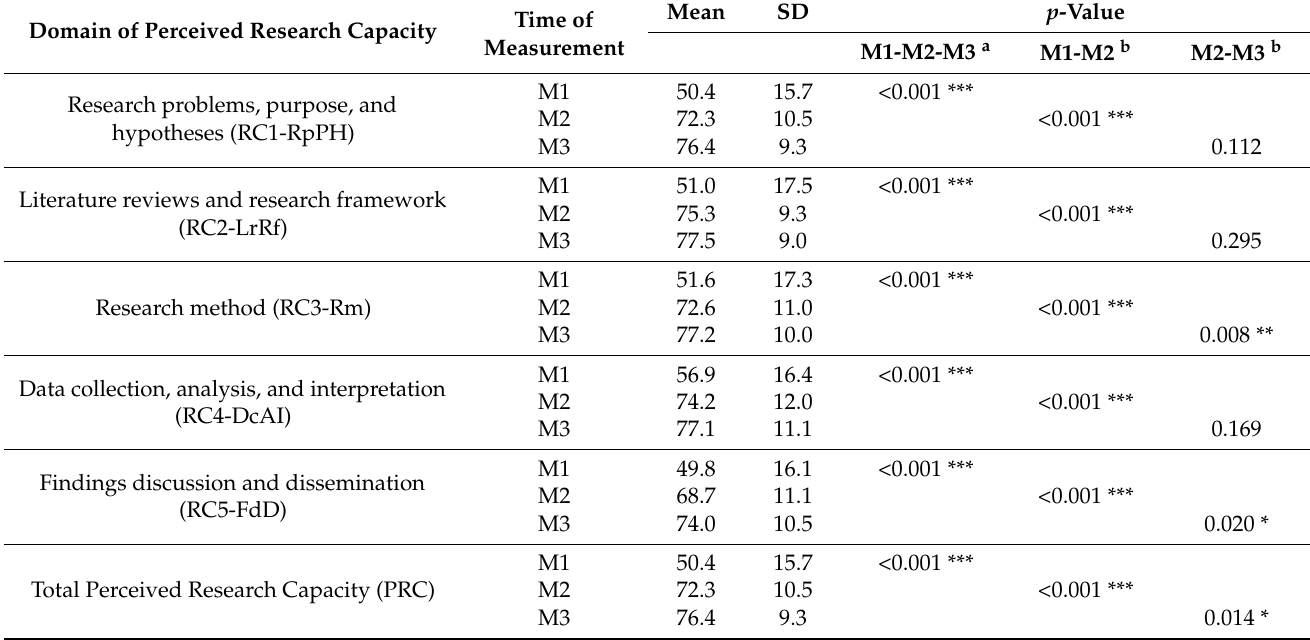
Table 9. Mean scores of participants’ PRC before, after 16, and after 32 weeks of the program ( n =